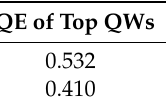
Table 1. IQE of each sets of QWs.